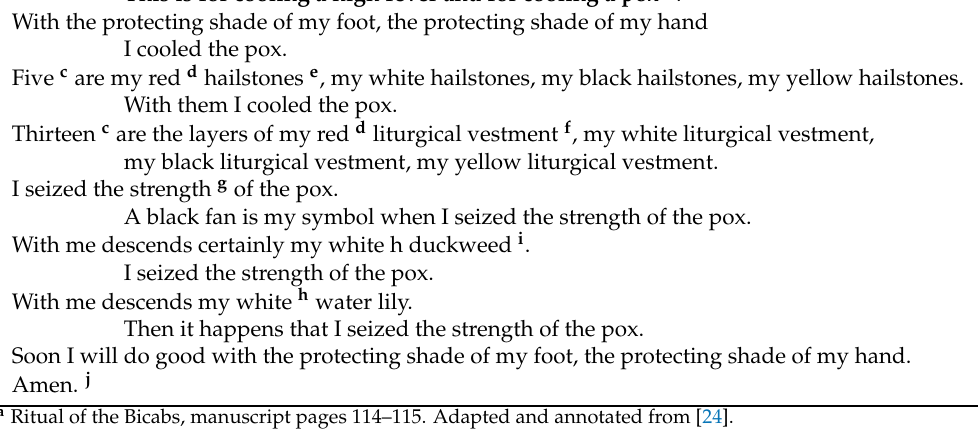
Table 3. Duckweed as the symbol of a cooling plant in the Ritual of the Bicabs a . This is for cooling a high fever and for cooling a pox b